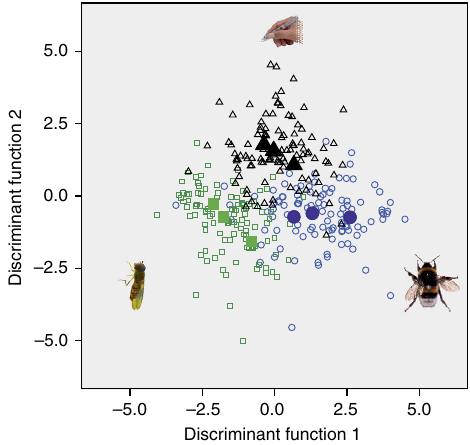
Figure 1 | Multivariate comparison of plants after experimental evolution. Plants of nine replicates (total sample size 323) at generation 11 were analysed using linear discriminant function analysis (bumblebee: blue circles, hoverfly: green squares, control hand pollination: black triangles; filled symbols are group centroids of replicates). The analysis comprised morphological traits (petal length and width, flower diameter, pistil length, plant height) and all floral volatiles. In the analysis, only replicates, not differences among replicates, replicates within treatments resemble each other more than replicates across treatments. The evolved differences